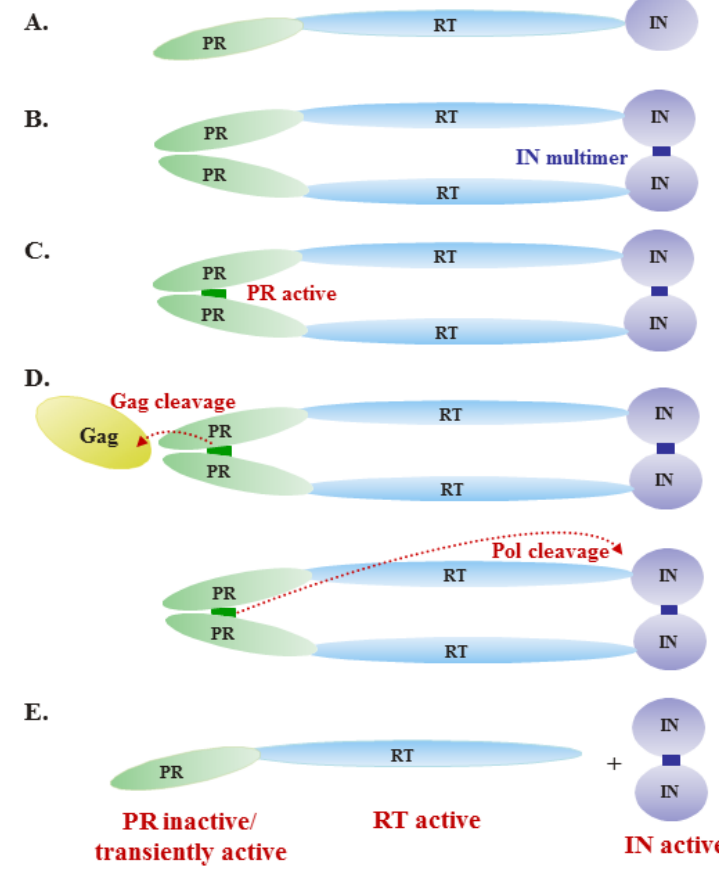
Figure 2. Model of regulation of Pol enzymatic activities during virus assembly. ( A ) The precursor Pol protein contains the protease (PR), reverse transcriptase (RT) and integrase (IN) domains. ( B ) Upon incorporation into virions, the precursor Pol protein forms dimers through IN-IN interactions. ( C ) The dimerization of precursor Pol allows formation of the PR active site. ( D ) Active PR cleaves Gag and Pol proteins, as indicated by the dashed lines. ( E ) After cleavage, PR-RT remains a monomer and is active as a polymerase, initiating reverse transcription of the viral RNA genome. Free IN is also